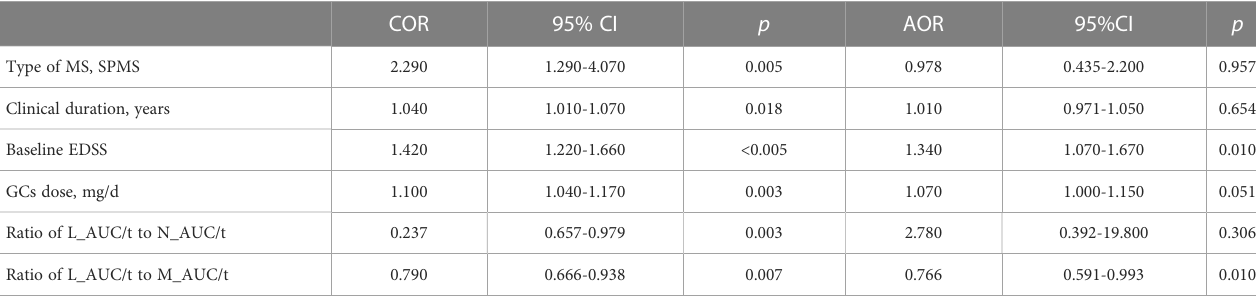
TABLE 3 Monovariate and multivariate regression analysis for infection.